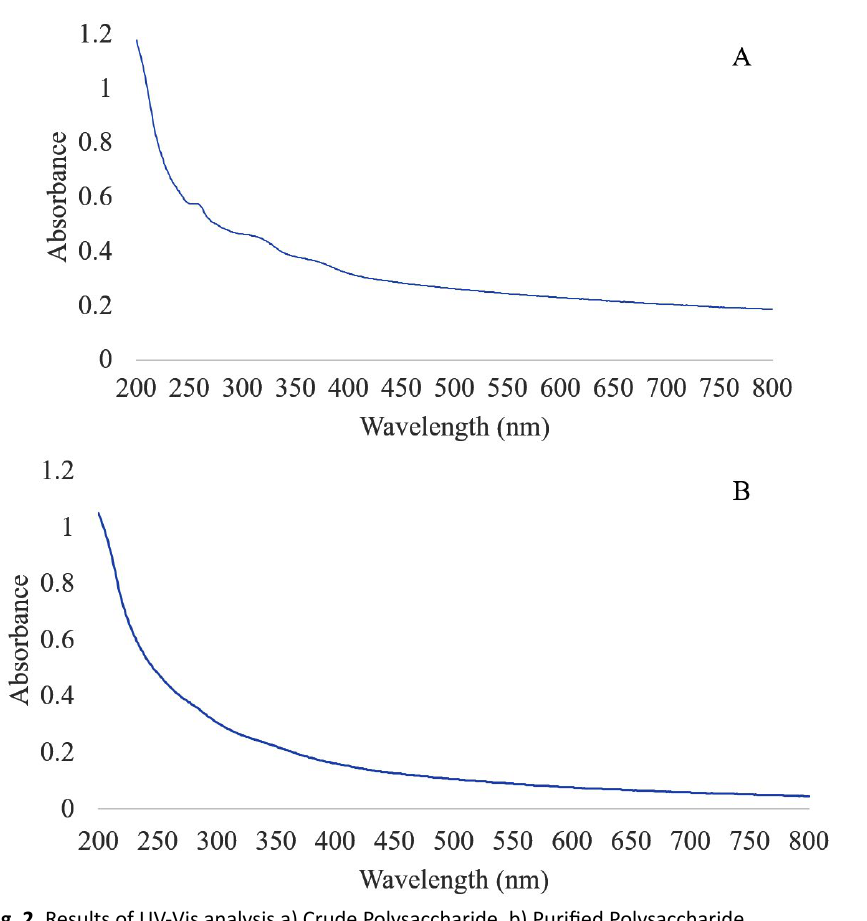
Fig. 2. Results of UV-Vis analysis a) Crude Polysaccharide, b) Purified